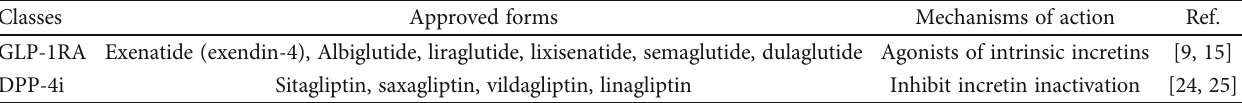
Table 1: The two main classes of incretin-based antidiabetic drugs.